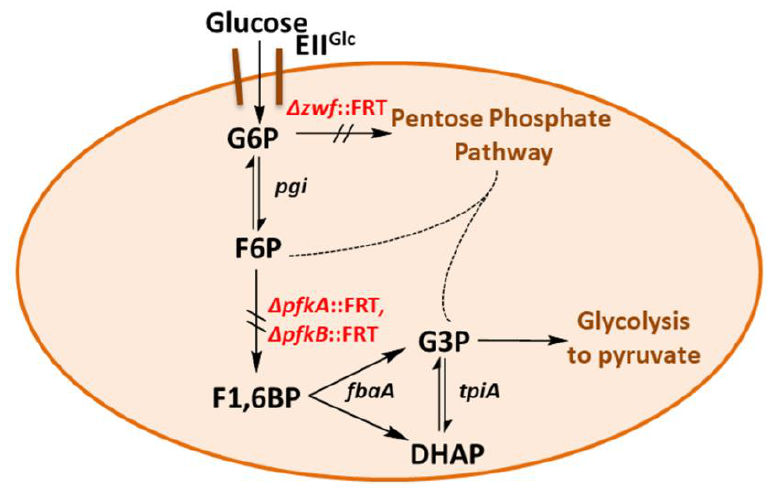
Figure 1. Schematic of the glycolytic blockage in the triple deletion strain, GL3. Genes encoding relevant enzyme activities are fbaA (fructose 1,6-bisphosphate aldolase A), pfkA (phosphofructokinase A), pfkB (phosphofructokinase B), pgi (phosphoglucose isomerase), tpiA (triosephosphate isomerase), zwf (glucose 6-phosphate dehydrogenase), EII Glc (glucose-specific enzyme II of the PEP-dependent sugar:phosphotransferase system, PTS), FRT = FLP recognition